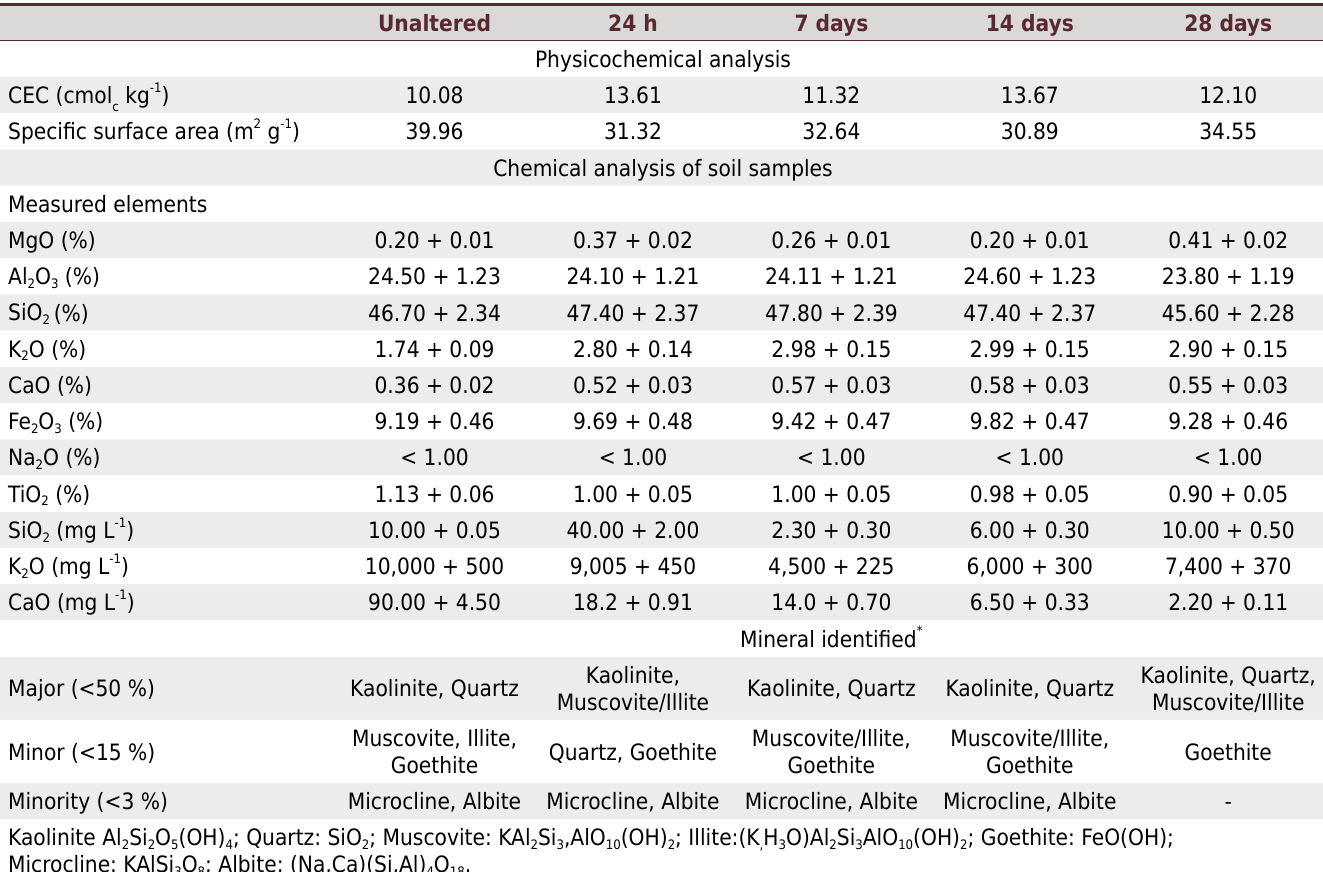
Table 1. Characterization of the soil samples and chemical analysis of solutions for each alteration